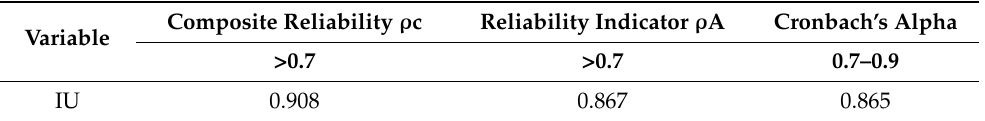
Table 4. Reliability of the reflective variable.